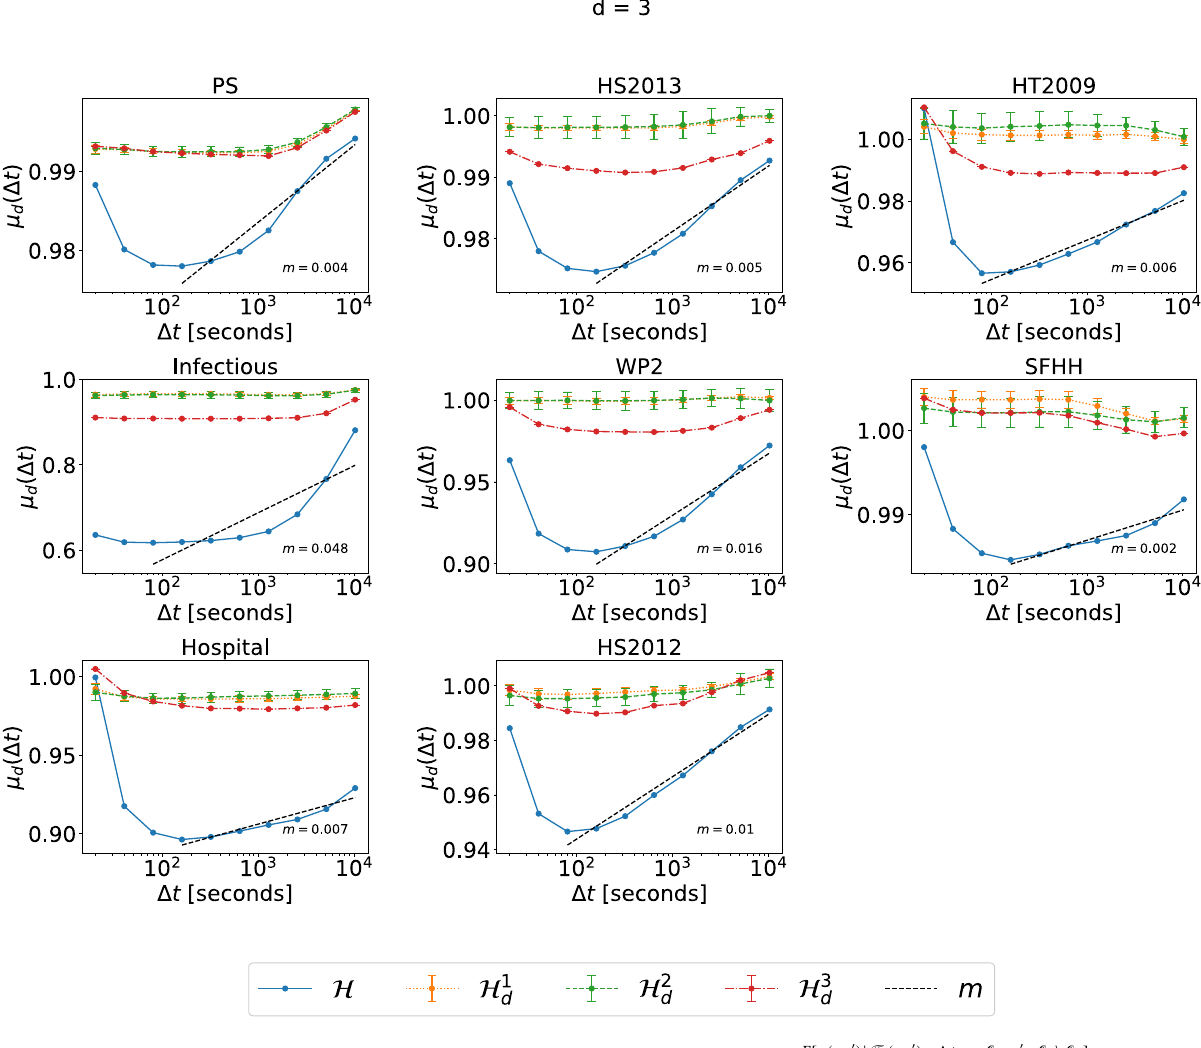
Figure 1. The normalized average topological distance µ d (� t ) = E [ η( e , e ′ ) | e ∈ E d , e ′ ∈ E \ E d ] , between an order d = 3 event and an event of a different order, in each physical contact network and its corresponding three randomized null models H 1 d (yellow), H 2 d (green) and H 3 d (red), which preserve or destroy specific properties of order d = 3 events. lim � t →∞ E [ η( e , e ′ ) | T ( e , e ′ ) < � t , e ∈ E d , e ′ ∈ E \ E d ] = E [ η( e , e ′ ) | e ∈ E d , e ′ ∈ E \ E d ] for any d . The horizontal axes are presented in logarithmic scale. The dashed line in each figure corresponds to the linear fit (with slope m ) of µ d (� t ) as a function of log 10 (� t ) in H , for the part that the curve has an increasing trend. For each dataset, the results of the three corresponding randomized models are obtained from 10 independent